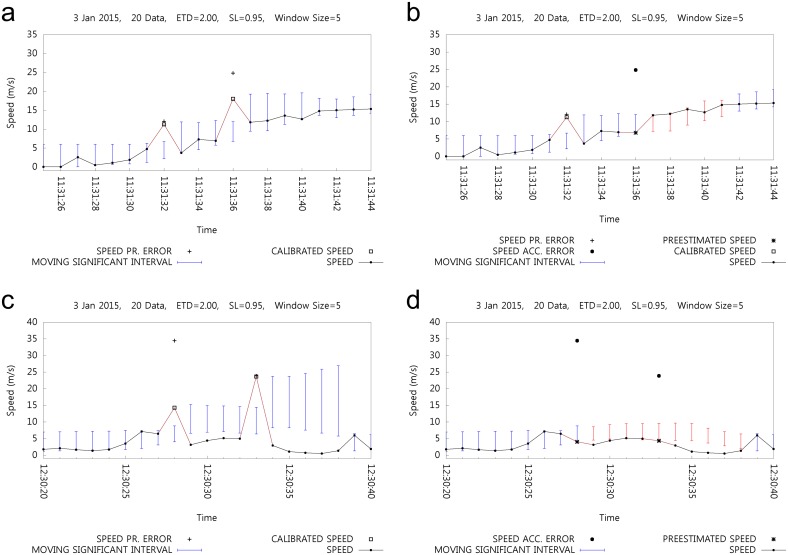
Effect of Acceleration Error.